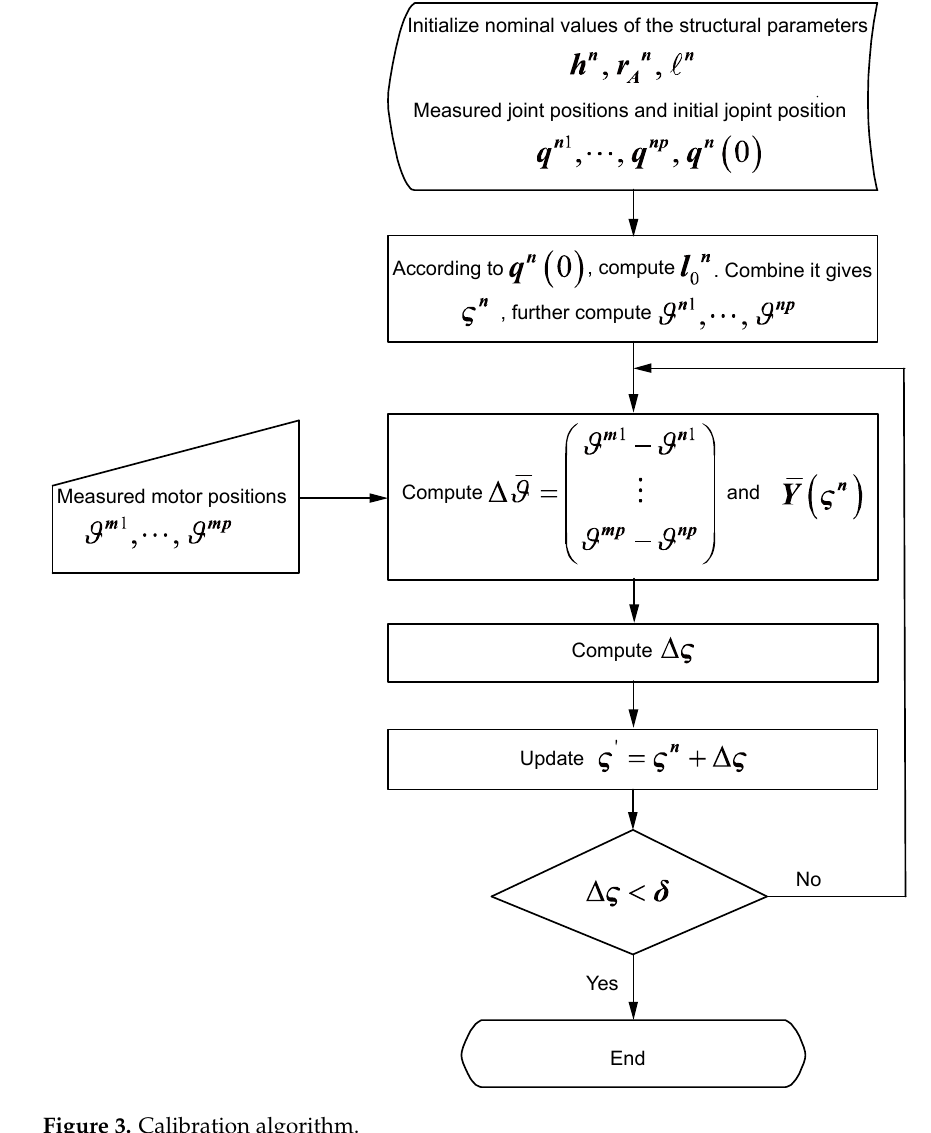
Figure 3. Calibration algorithm.